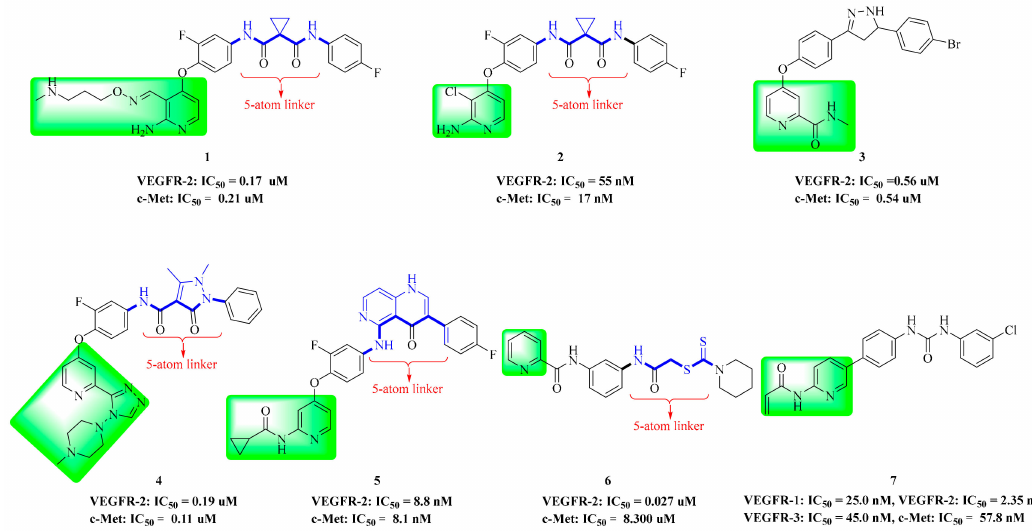
Figure 3. Pyridine derivatives of dual VEGFR / c-Met inhibitors.